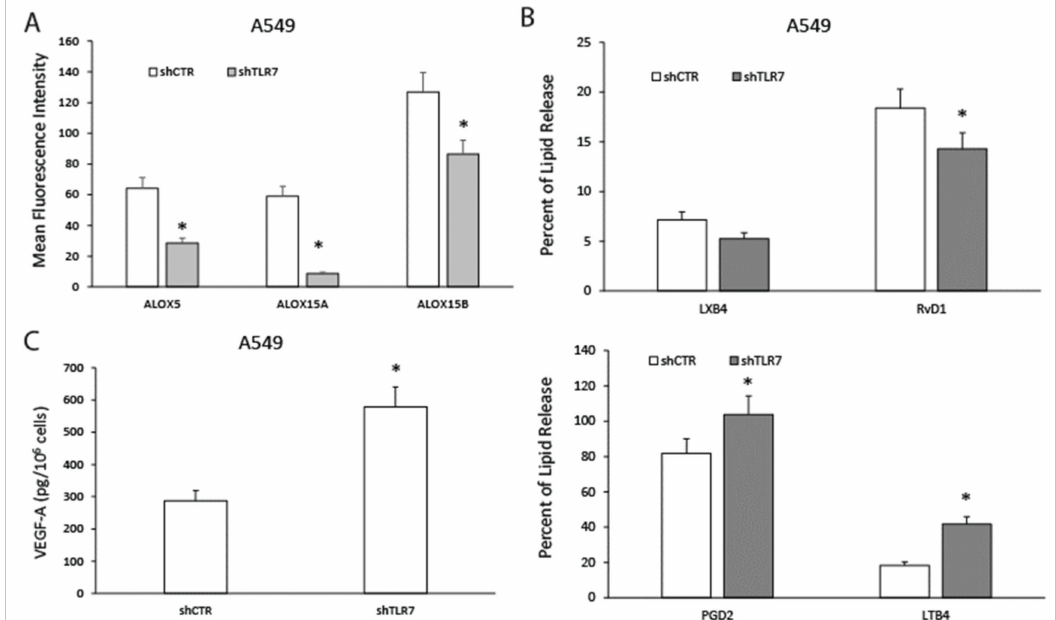
Figure 3. Effects of TLR7 silencing on the specialized pro-resolving mediator (SPM) biosynthetic machinery of NSCLC cells. ( A ) ALOX5, ALOX15A, and ALOX15B protein expression levels (mean fluorescence intensity), assessed by cytofluorimetric analysis, in A549 shTLR7 (two clones) cells and the relative control (shCTR, a mass population). Data are represented as mean ± SD of five independent experiments. * p < 0.05 compared to the relative control. ( B ) Pro-resolving and pro- inflammatory autacoids (LXB4, RvD1, PGD2, and LTB4) release in A549 shCTR (a mass population) or shTLR7 (two clones). Data are represented as mean ± SD of five independent experiments. * p < 0.05 compared to the relative control. ( C ) Spontaneous VEGF-A release in A549 shCTR (a mass population) or shTLR7 (two clones). Data are represented as mean ± SD of five independent experiments. * p < 0.05 compared to the